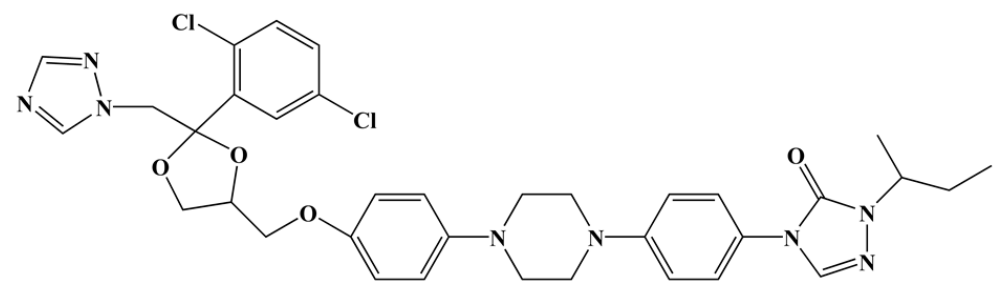
Figure 1. Chemical structure of the itraconazole.